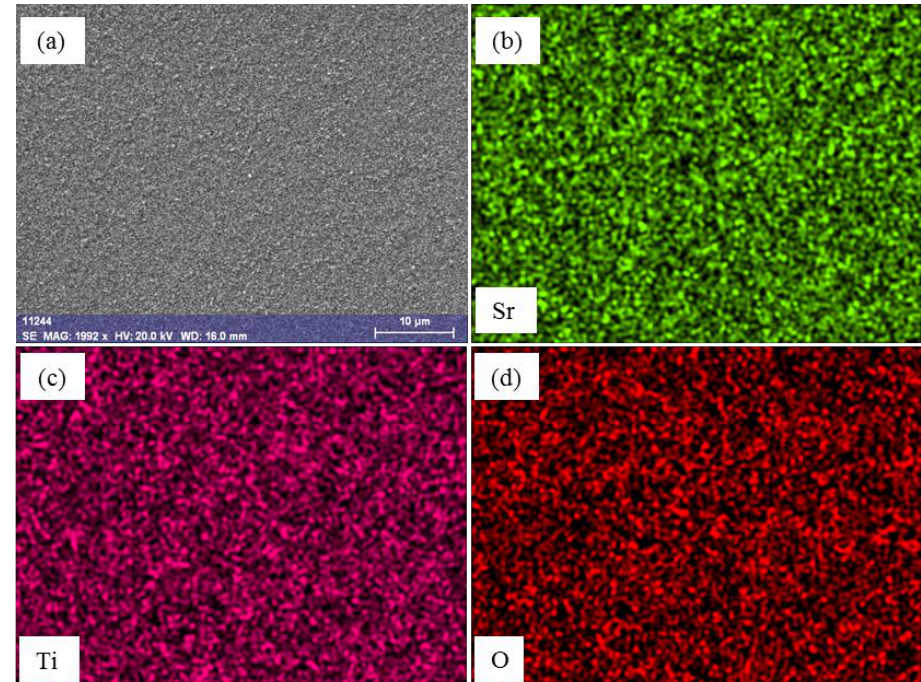
Figure 5. SEM photo with EDS analysis taken for 350 nm SrTiO 3 -TiO 2 at FTO: ( a ) SEM photo at 1992× magnification; EDS mapping of ( b ) Sr, ( c ) Ti and ( d ) O elements.